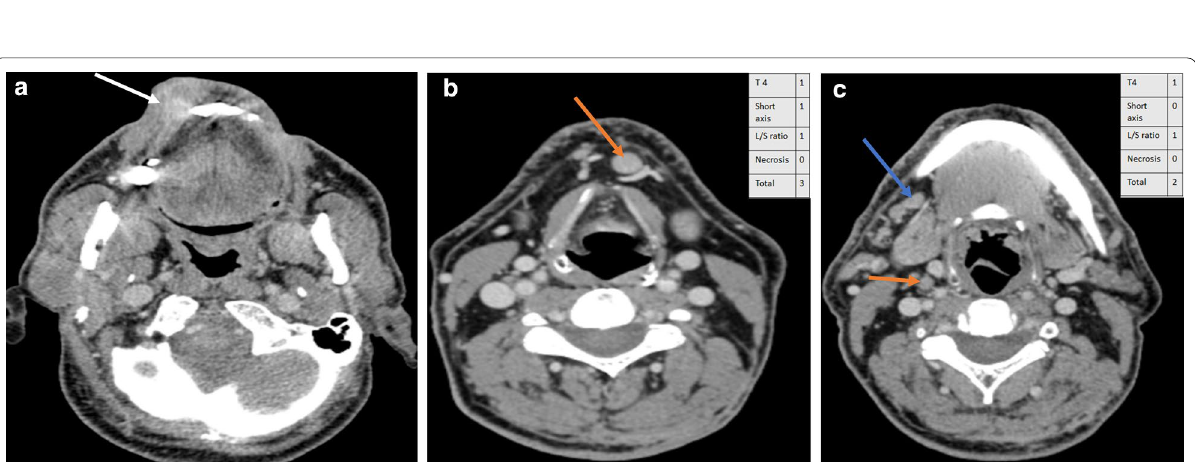
15 mm with × 12 mm × 32 mm with necrosis (score 9) (orange arrow). ×